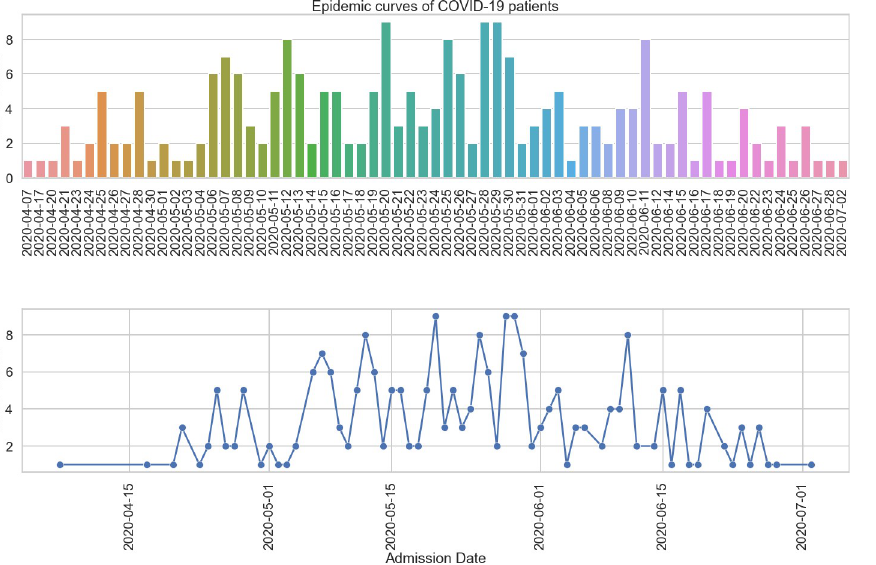
Fig 1. Epidemic curve of COVID-19 cases at the Djoungolo Hospital.